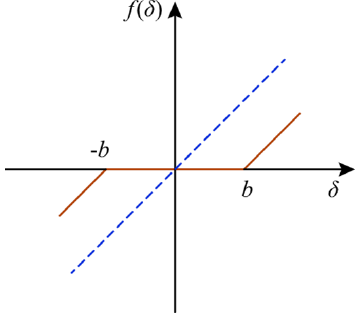
Figure 12. Schematic diagram of backlash function.